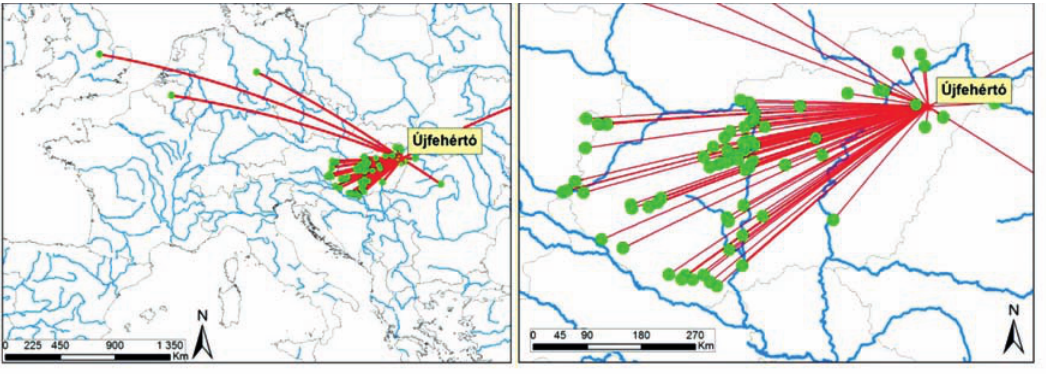
Figure 10. Map of